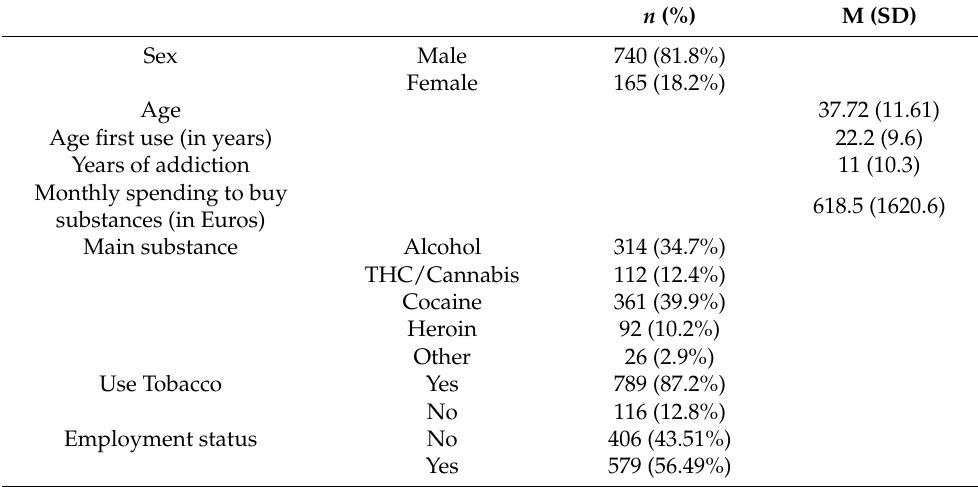
Table 1. Characteristics of the